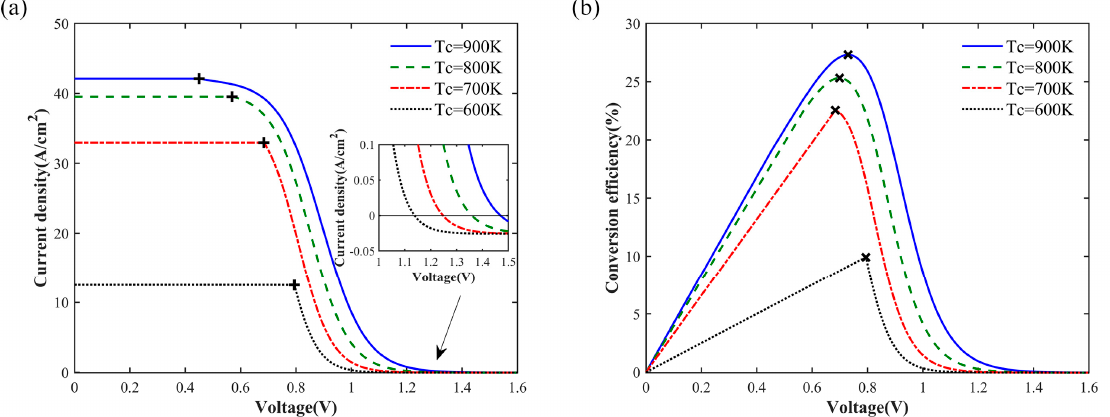
Figure 7. At different cathode temperatures, T a = 500 K, and χ = 0.6 eV, the curve of ( a ) the current voltage and ( b ) the efficiency voltage. “+” represents the flat-band voltage, and “×” represents the output voltage V m at maximum conversion efficiency.